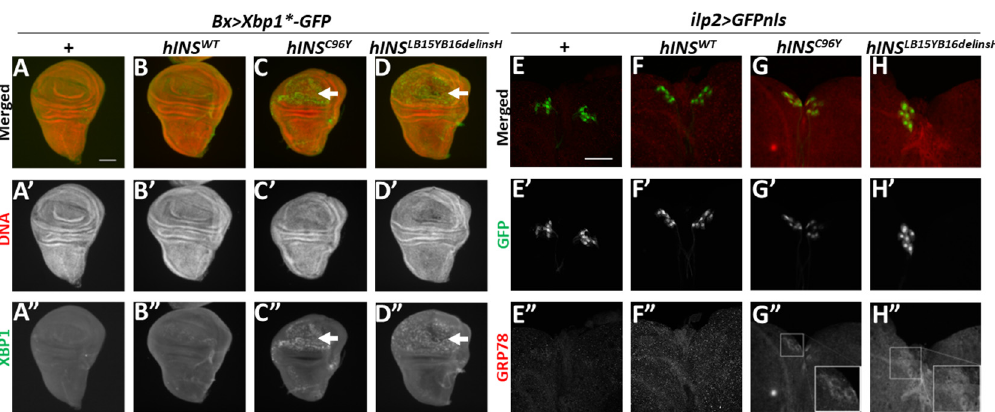
Figure 1. Induction of UPR observed in wing imaginal discs and larval IPCs harboring the ectopic expressing human mutant preproinsulin. ( A – D ) Xbp1-GFP fluorescence (green in ( A – D ), white in ( A” – D” ), arrows in ( C , C” ) and ( D , D” )) produced because of ER stress-dependent splicing of Xbp1*-GFP mRNA in wing imaginal discs. Red in ( A – D ) (white in ( A’ – D’ )): DNA staining. ( A – A” ) A control wing imaginal disc ( Bx-Gal4/+ ; UAS-Xbp1*-GFP ). ( B – B” ). A wing imaginal disc expressing hINS WT in the wing pouch region ( Bx > hINS WT , Xbp1*-GFP ). ( C – C” ) A wing imaginal disc expressing hINS C96Y ( Bx > hINS C96Y , Xbp1*-GFP ). ( D – D” ) A wing imaginal disc expressing hINS LB15YB16delinsH ( Bx > hINS LB15YB16delinsH , Xbp1*-GFP ). Scale bar: 100 µ m. ( E – H ) Anti-GRP78 immunostaining (red in ( E – H ), white in ( E” – H” )) of brains the ectopically expressing GFPnls in IPCs from third-instar larvae. IPC nuclei are visualized by GFP expression (green in ( E – H ), white in ( E’ – H’ )). ( E – E” ) A control larval brain ( ilp2 > GFPnls ). ( F – F” ) A Larval brain with IPC-specific expression of hINS WT ( ilp2 > hINS WT , GFPnls ). ( G – G” ) A Larval brain expressing hINS C96Y in IPCs ( ilp2 > hINS C96Y , GFPnls ). ( H – H” ) A Larval brain expressing hINS LB15YB16delinsH in IPCs ( ilp2 > hINS LB15YB16delinsH , GFPnls ). Insets in ( G” ) and ( H” ) present a magnified view of the IPC cluster. Scale bar: 50 µ